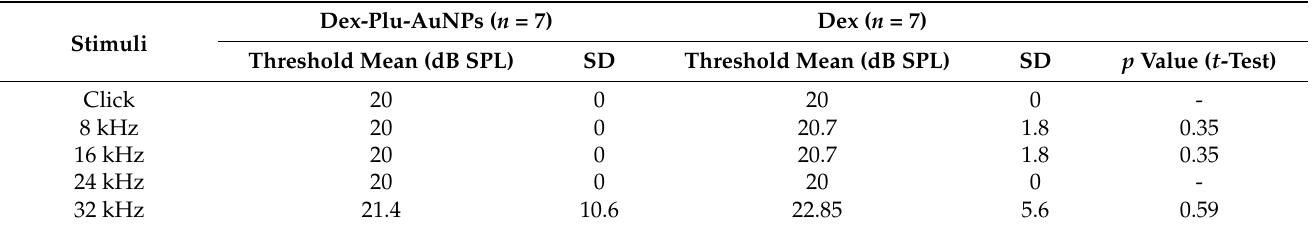
Table 1. Preoperative frequency-specific hearing threshold (dB SPL) for both the Dex-Plu-AuNP and Dex groups.